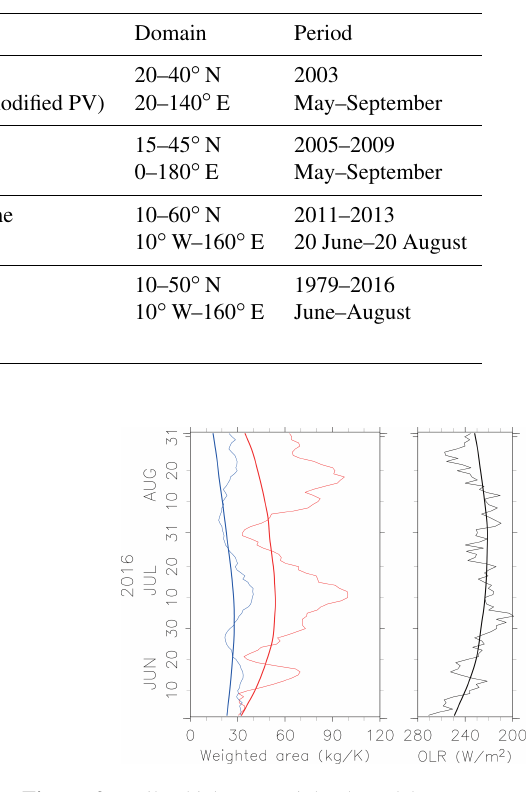
Figure 2. Daily thickness-weighted total low-PV area defined at 360K (red curves) and 370K (blue curves), and the OLR averaged over 15–30 ◦ N, 60–120 ◦ E, from June to August. Thin curves repre- sent the daily data for 2016, and thick curves are for the 31d filtered Figure 1. (a) Daily mean PV map at the 370K isentropic level. The area of PV values below 2PVU, defined as the area inside the AMA, is hatched by red dots. (b) Daily mean σ and horizontal wind. Values are shown only for the area inside the AMA. (c) A schematic description of ˆ A west and flux ˆ F λ . The reference longitude λ 0 is set 0 to 70 ◦ E in this example.